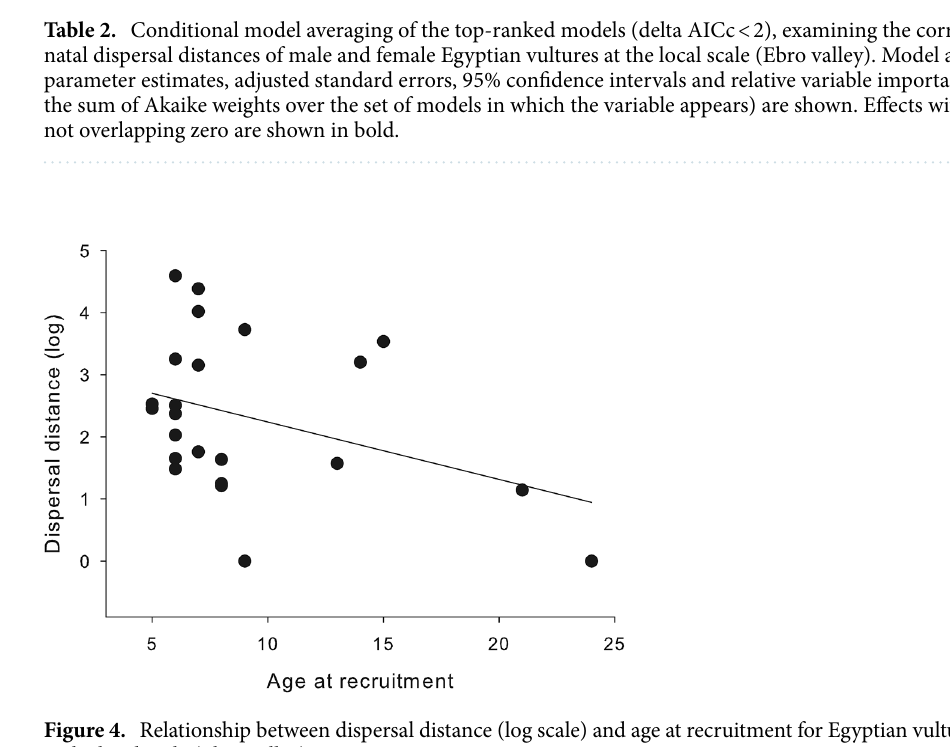
Figure 4. Relationship between dispersal distance (log scale) and age at recruitment for Egyptian vulture males at the local scale (Ebro